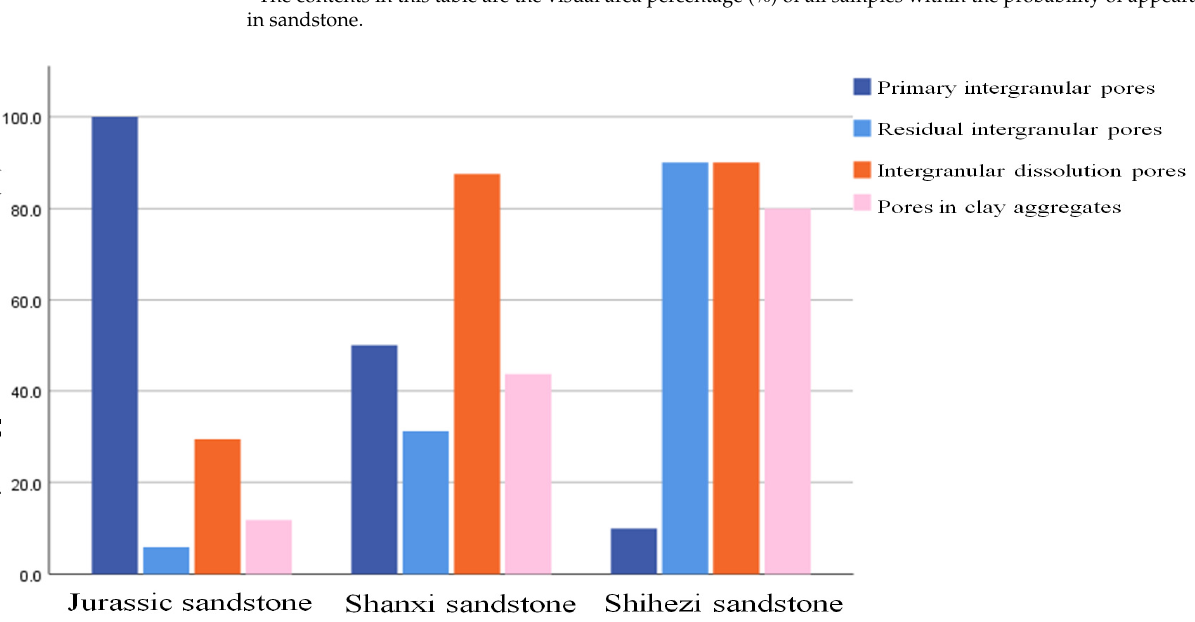
Figure 4. Types and appearance probabilities of intergranular pores in three layers of sandstone (%).